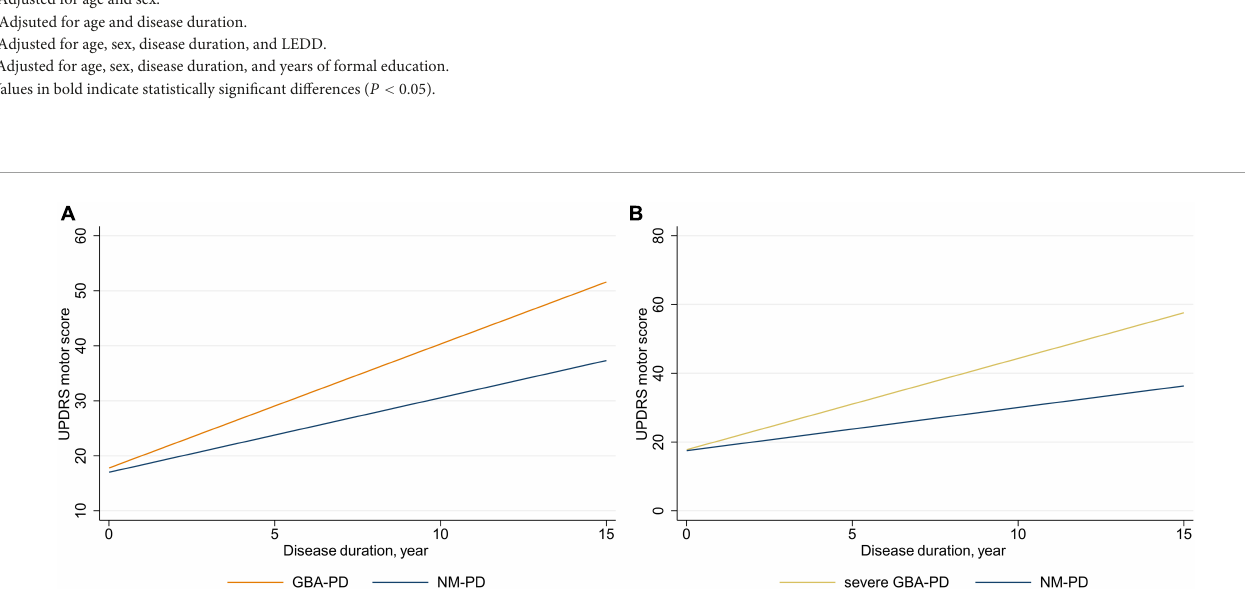
FIGURE1 Longitudinal trajectories of mean Unified Parkinson’s Disease Rating Scale (UPDRS) motor scores. (A) GBA -PD vs. NM-PD; (B) severe GBA -PD vs. NM-PD. GBA -PD, GBA -related PD; NM-PD, non- GBA -mutated PD; PD, Parkinson’s